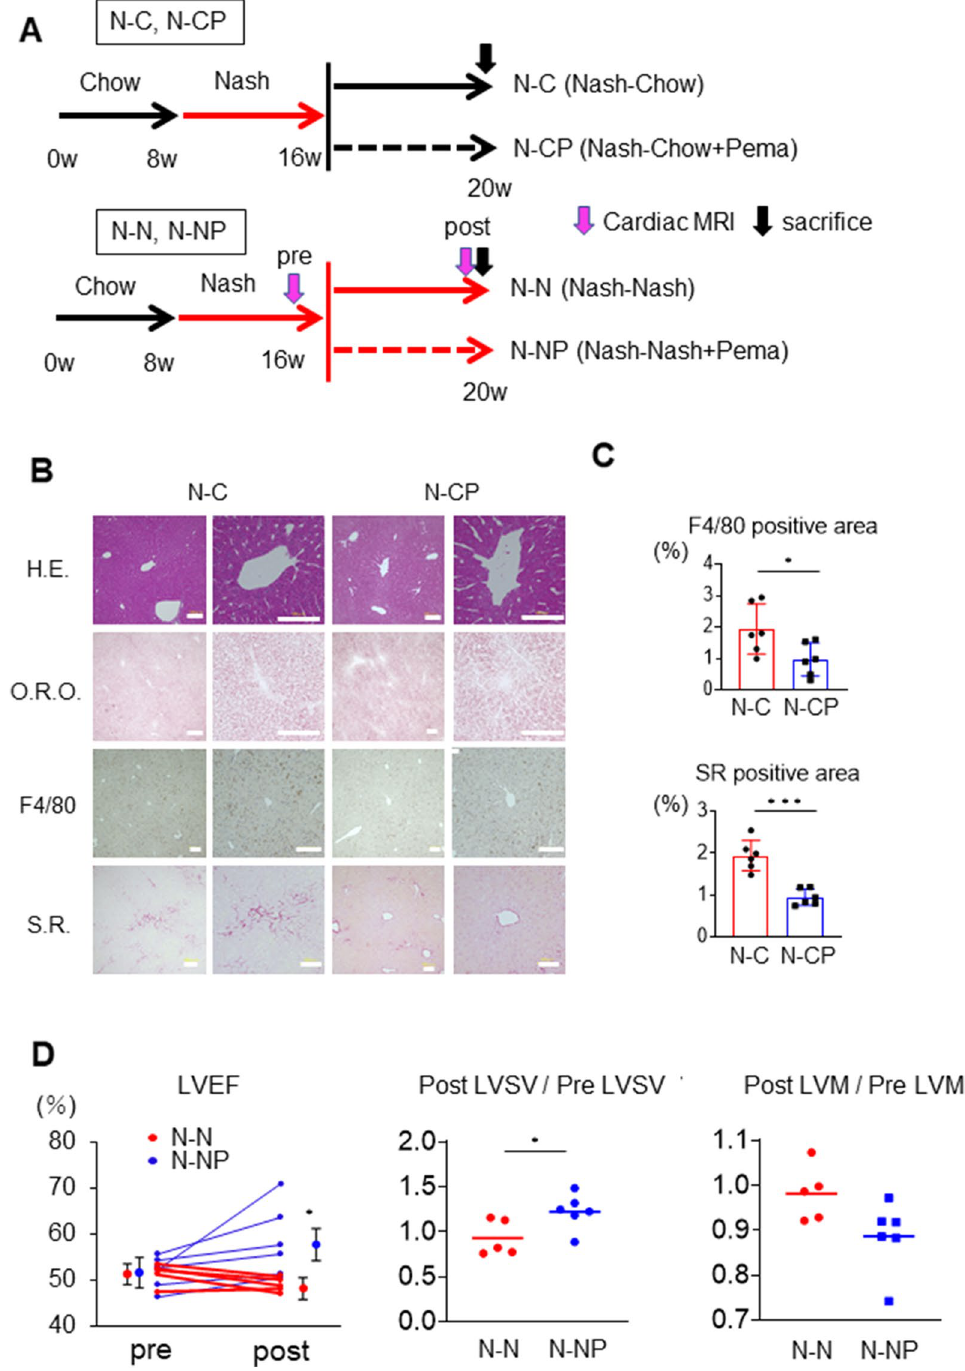
Figure 6. Effect of pemafibrate after the development of steatohepatitis and cardiomyopathy. ( A ) Chow diet, chow diet + 0.1 mg/kg pemafibrate, NASH diet, or NASH diet + 0.1 mg/kg pemafibrate diet was fed to C57Bl6 male mice for 4 weeks after feeding the NASH diet for 8 weeks (N–C, N-CP, N–N, and N-NP groups, respectively). Cardiac MRI was performed before and after the additional diet in the N–N and N-NP groups. ( B ) Liver H. E, O.R.O., F4/80, and S.R. staining in N–C and N-CP groups. ( C ) Percentages of examined areas positive for F4/80 and Sirius Red. ( D ) LVEF, LVSV, and LVM in N–N and N-NP groups. Pre- and post-LVEF, the ratios of post/pre LVSV and post/pre LVM are shown. Scale bar: 100 µm. The results are presented as the mean ± SD, and p values were calculated using Student’s t test. * P < 0.05, N–C vs. N-CP or N–N vs. N-NP group. The number of mice in each group: N–C, n = 6; N-CP, n = 6; N–N, n = 6; N-NP, n = 6. H.E., haematoxylin–eosin; O.R.O., Oil Red O; S.R., Sirius Red; LVEF, left ventricle ejection fraction; LVSV, left ventricular stroke volume; LVM, left ventricular